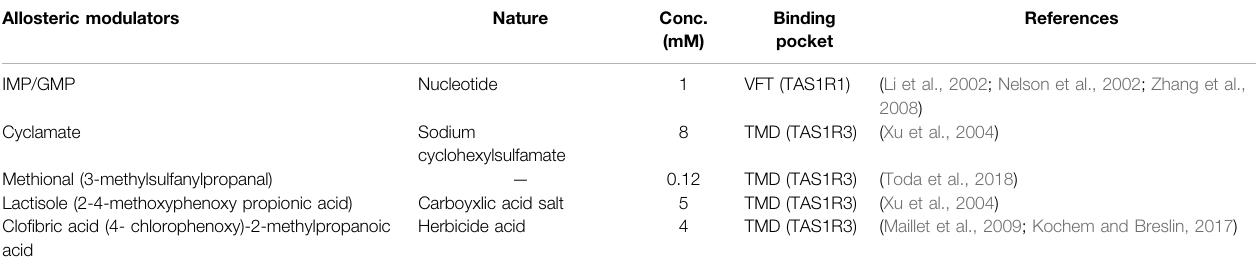
TABLE 6 | Umami receptor allosteric modulators with conc. used in cell based assays and other pharmacological properties. Allosteric